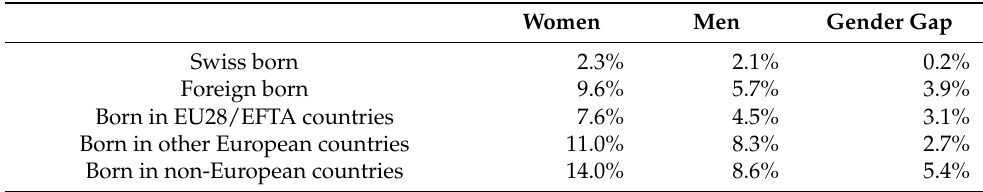
Table 2. Unemployment Rates of Highly skilled Individuals in Switzerland by Gender and Country of Birth (15–60 years old), 2017.